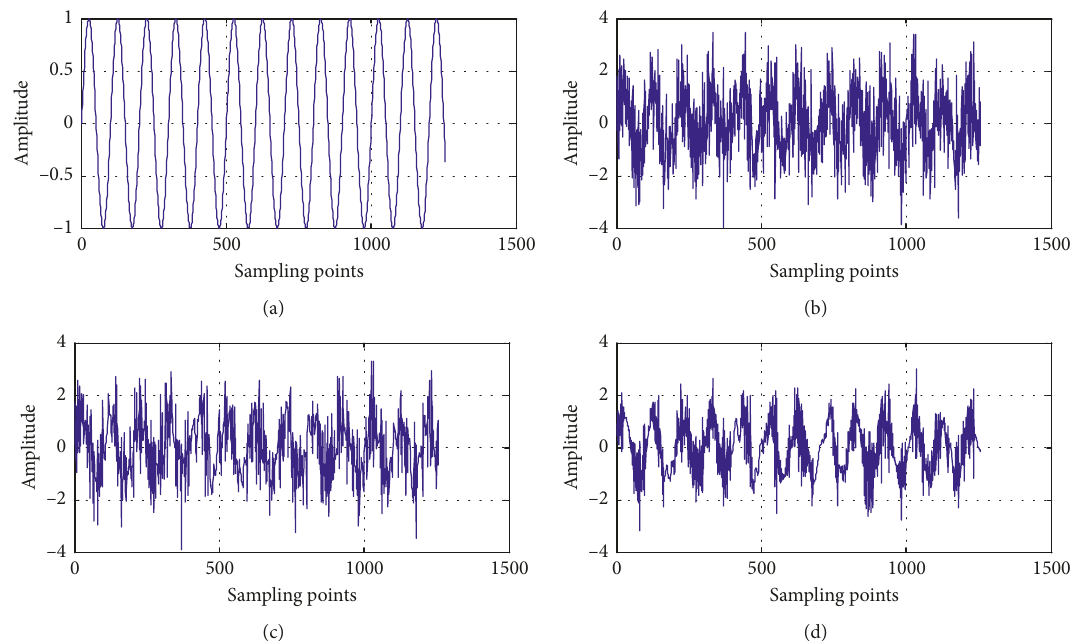
Figure 7: Adaptive threshold denoising processing of simulated signal. (a) Original signal. (b) Containing noise signal. (c) Denoising at a given threshold. (d) Adaptive threshold denoising.